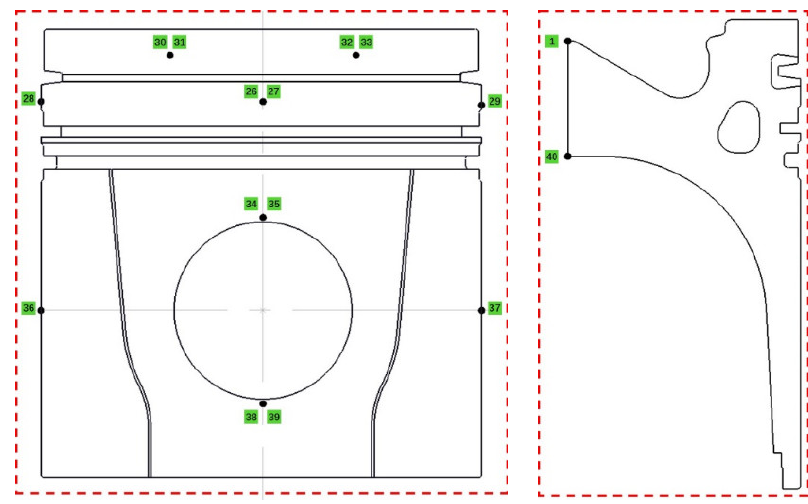
Figure 4. The distribution of the MPs on the other side.